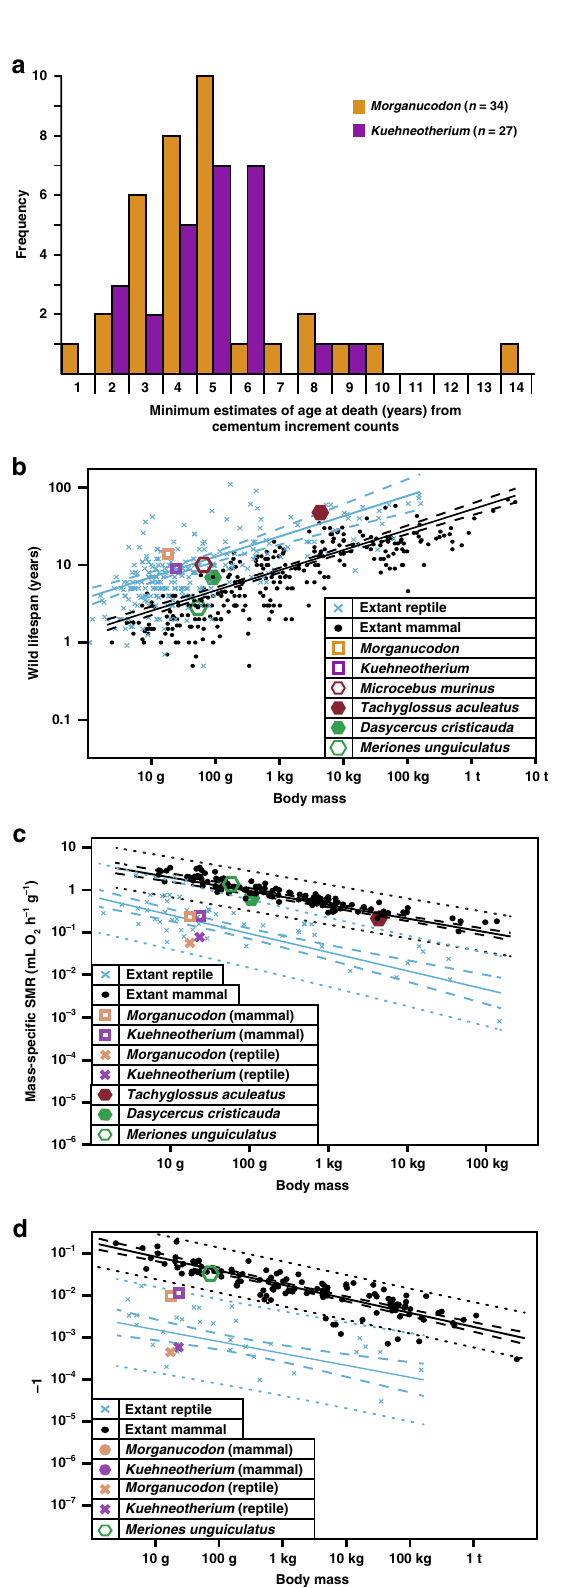
We estimated growth rates using PGLS correlations between maximum wild lifespan and growth rate 33,34 from published data from 115 extant mammals and 30 extant reptiles ( “ Methods ” ; Supplementary Data 3 and Fig. 6b). From mammal data, we